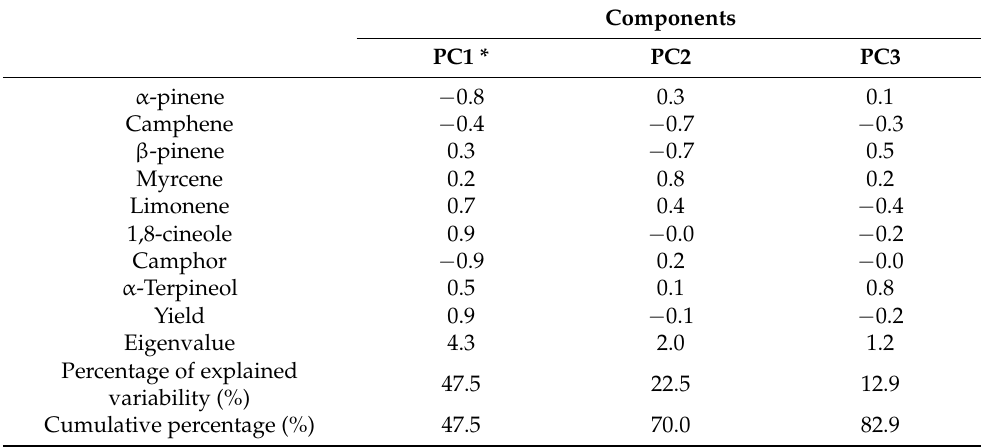
Table 2. Quality of representation of the variables on the first three components, eigenvalues of the components, percentages of variability explained, and cumulative